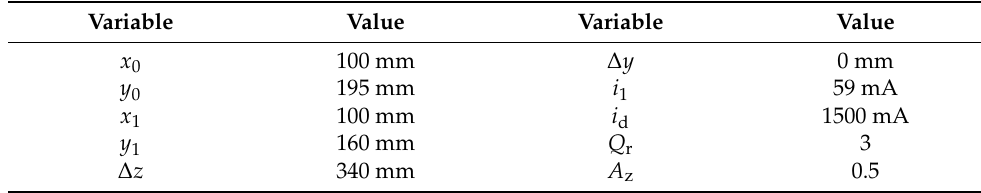
Table 4. Some parameters of the BTS.